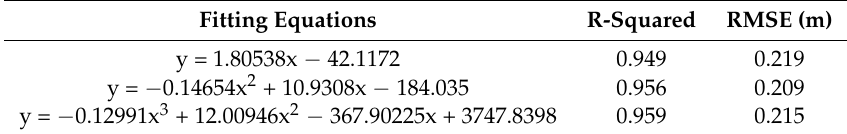
Table 2. Statistical characteristics of the two constructed models.